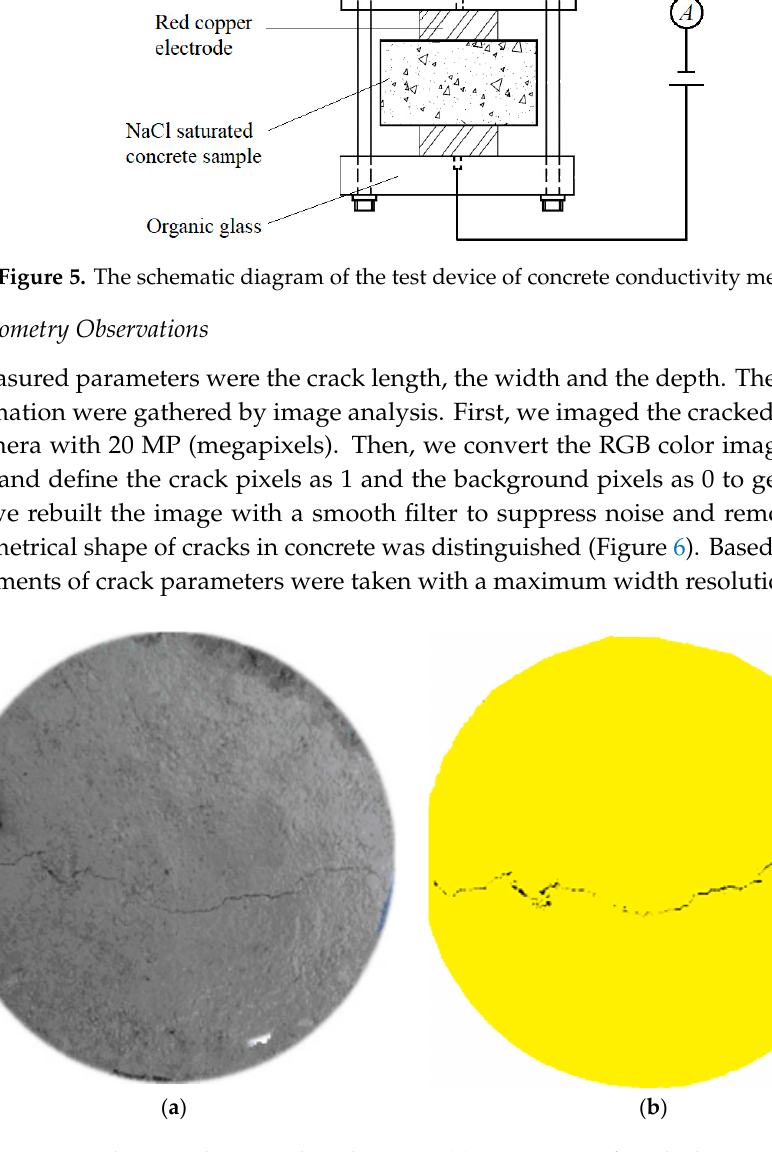
Figure 7. Measurement of crack depths. 4. Correlation between the Crack Depth h and Width w The scaling of depth to width is defined as follows: / h w λ=